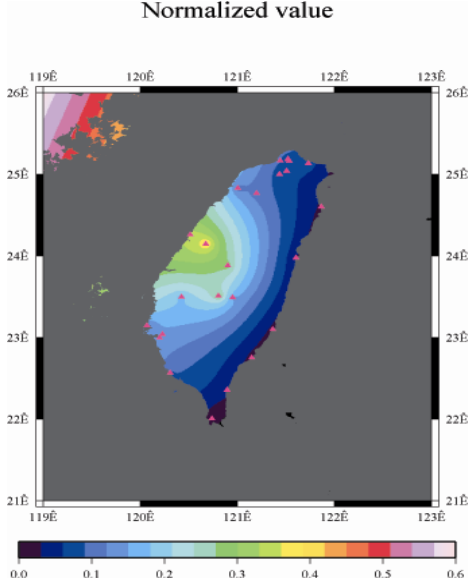
Figure 16. Normalized rainfall values around the island after the typhoon struck Taiwan (September 15th, 2008, 9:00